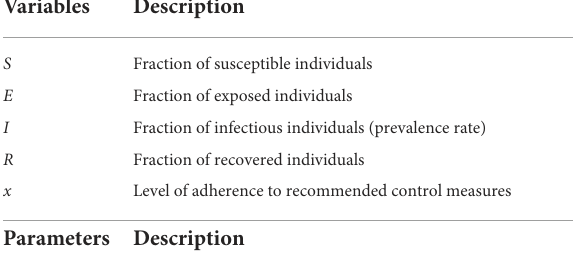
TABLE 1 Description of state variables and model